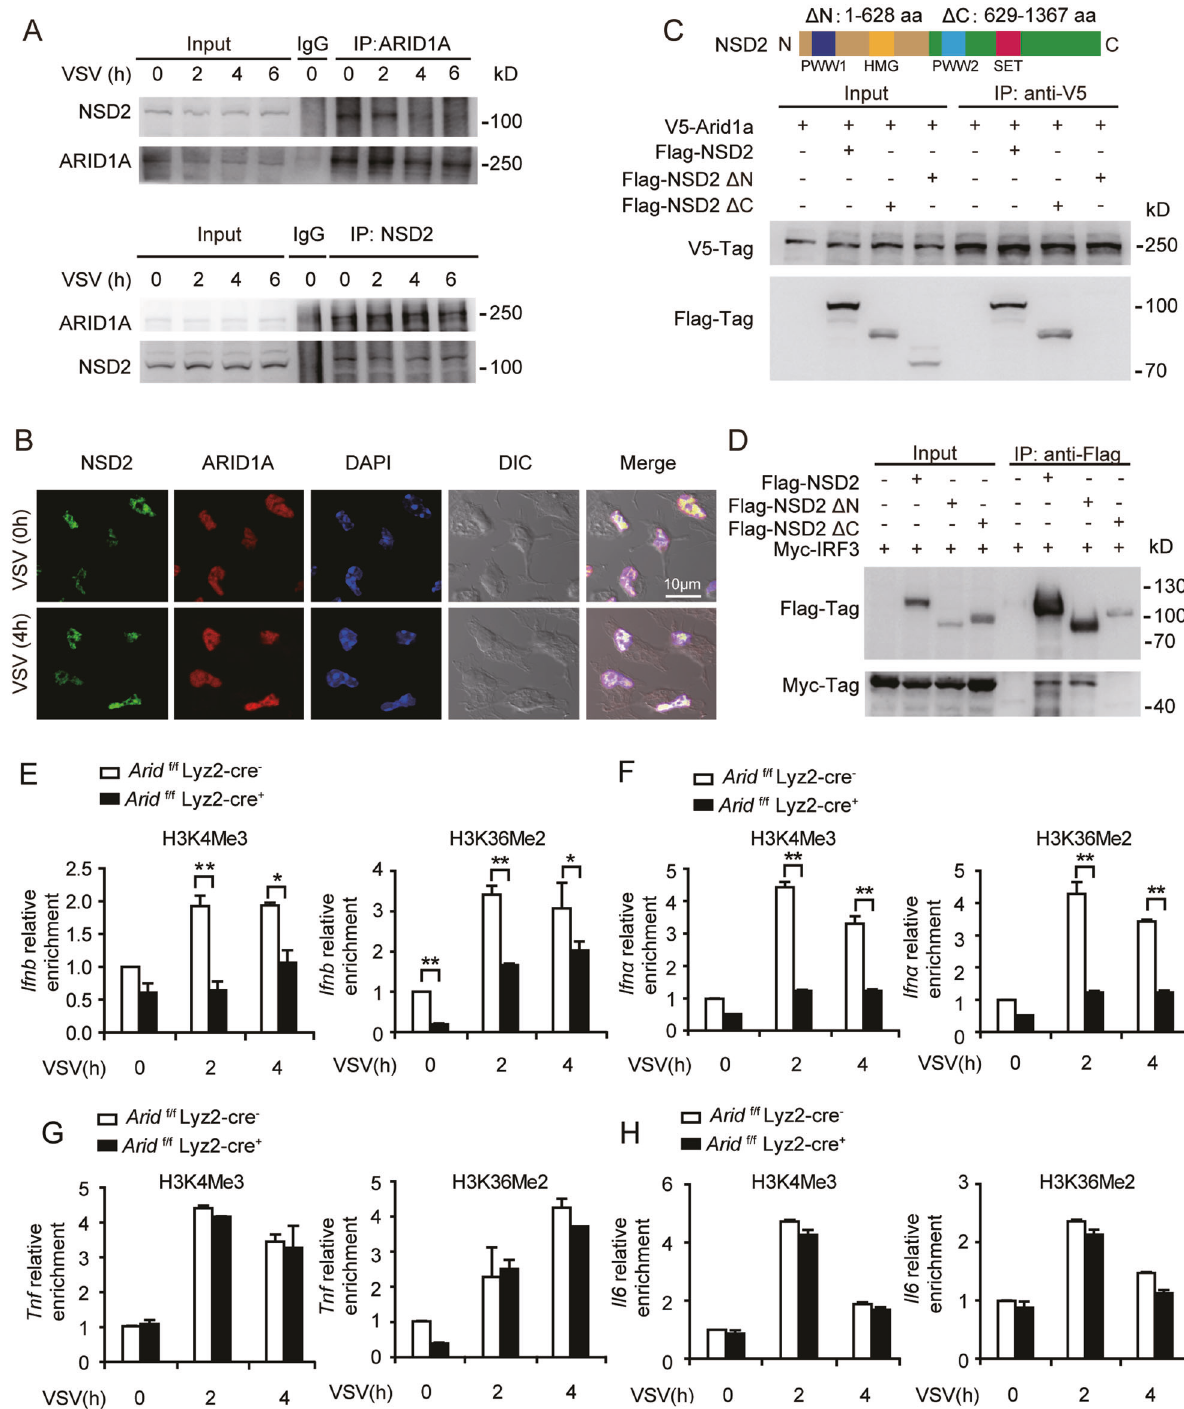
Fig. 4 ARID1A interacts with NSD2 to promote methylation of Ifn-I promoters. A Co-IP analysis of the interaction between endogenous ARID1A and NSD2 in macrophages. B Immuno fl uorescence of ARID1A and NSD2 localization in macrophages (scale bar: 10 μ m). C Co-IP analysis of the interaction between tagged ARID1A and tagged wild type NSD2 or indicated NSD2 mutants in HEK293T cells. D Co-IP analysis of the interaction between tagged IRF3 and tagged wild type NSD2 or indicated NSD2 mutants in HEK293T cells. E – F ChIP assay of H3K4Me3 and H3K36Me2 in the Ifnb ( E ) and Ifn α ( F ) promoter regions of Arid1a f/f Lyz-Cre − and Arid1a f/f Lyz-Cre + BMDMs with VSV infection (MOI, 1) at the indicated times. G , H ChIP assay of H3K4Me3 and H3K36Me2 in the Tnf α ( G ) and Il6 ( H ) promoter regions of cells as in ( E – F ). All data are representative of three independent experiments with three biological replicates. * P < 0.05, ** P < 0.01. ( E – H : mean ± s.d.).